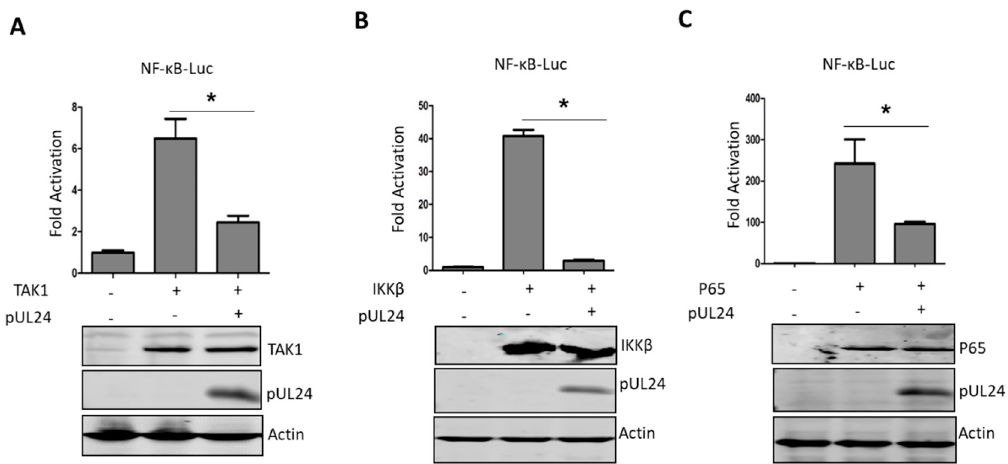
Figure 3. UL24 inhibits the TNF- α -mediated NF- κ B signaling pathway via p65. ( A ) HEK293T cells were transfected with 200 ng of the NF- κ B-Luc promoter reporter plasmid, the Renilla luciferase plasmid pRL-TK (50 ng), and 200 ng of TAK1 ( A ), IKK β ( B ), or p65 ( C ) expression plasmids along with pCAGGS-HA empty vector or pCAGGS -UL24 (200 ng), and luciferase activity was measured at 24 h post transfection. Cell lysates were analyzed by WB with Flag-specific antibodies to detect the expression of TAK1-Flag, IKK β -Flag, and p65-Flag, and HA-specific antibodies were used to detect UL24 expression. The data represent results from one of three independent experiments. Error bars represent standard deviations of data from three replicates of one independent experiment. * stands for p <